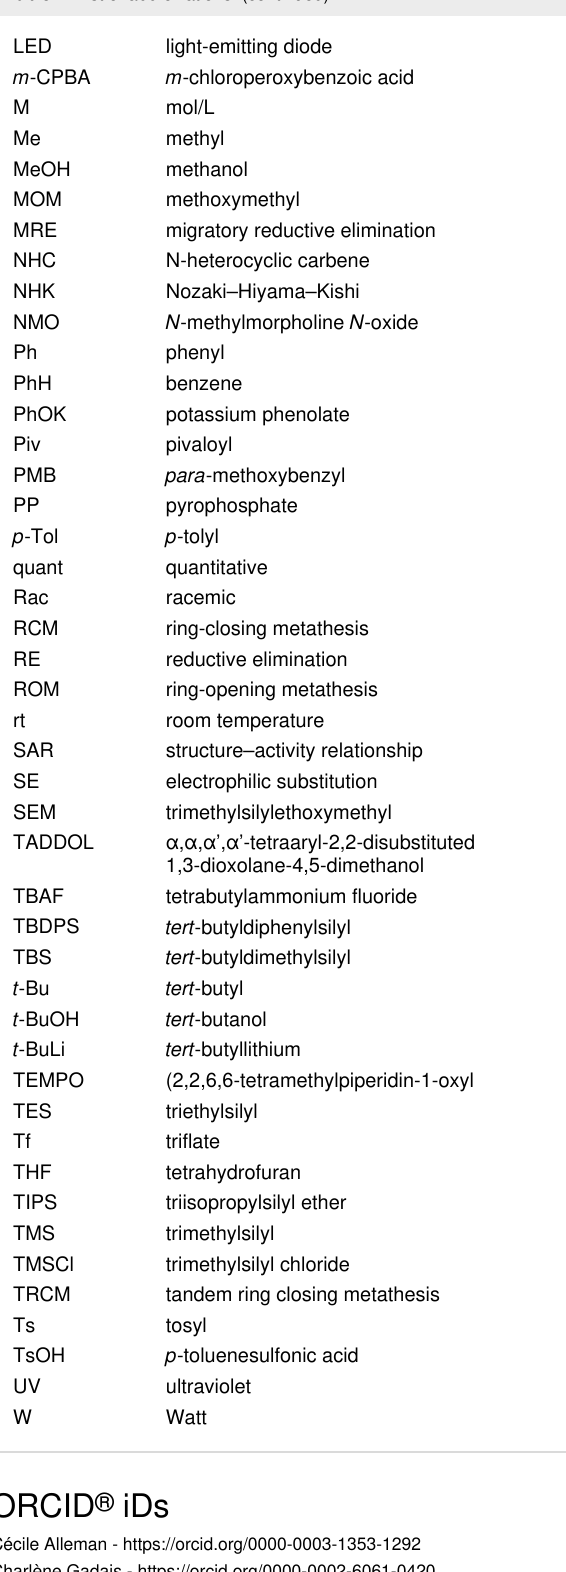
Table 1: List of abbreviations.